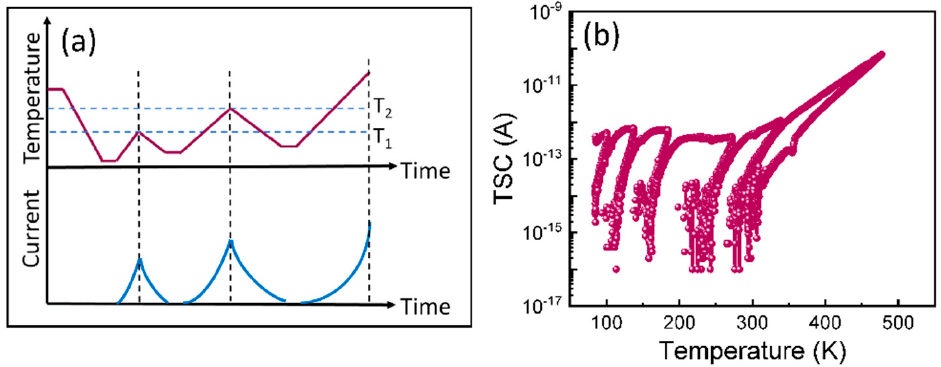
Figure 4. ( a ) Process flow of fractional emptying method for TSC peak resolution and ( b ) resolved peaks of TSC spectrum for all the traps.